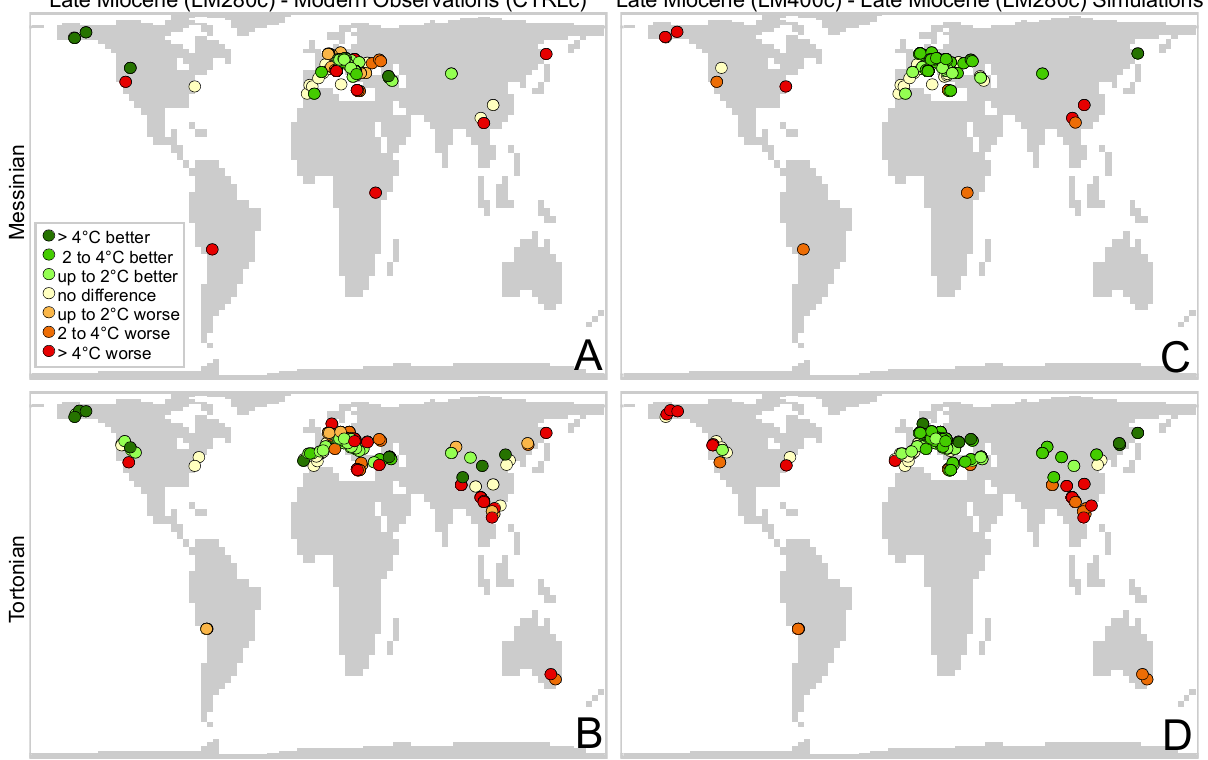
Fig. 10. Improvements in the model–data comparison for mean annual temperature. The lefthand column (A, B) shows the improvement that the late Miocene palaeogeography makes to the model–data comparison. The righthand column (C, D) shows the improvement that higher CO 2 makes to the model–data comparison. Green circles indicate an improvement; red circles indicate a deterioration. The datapoints showing “no difference” (white circles) are plotted underneath the other datapoints in order to highlight the